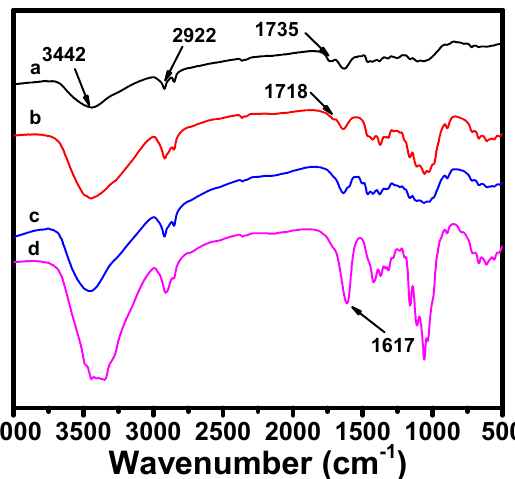
Figure 4. FTIR spectra of ( a ) velvetleaf bark, ( b ) alkali-treated velvetleaf bark, ( c ) bleached cellulose fibers, and ( d ) TCNFs.